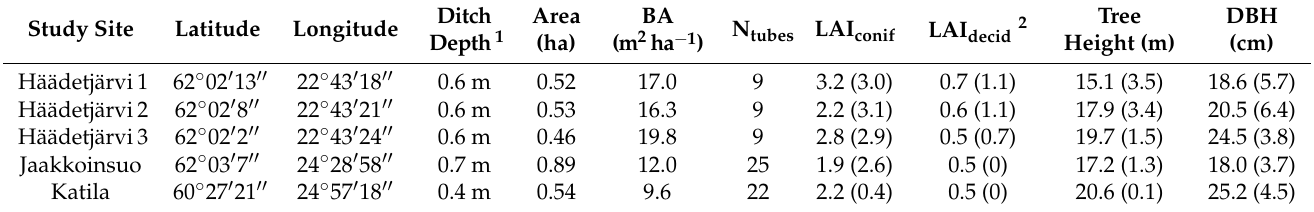
Table 1. Characteristics of the study sites. Tree stand characteristics refer to the adjacent unharvested stand. The standard deviation is presented in parenthesis. BA = stand basal area; N tubes = number of manual water table measurement points; LAI = average leaf area index (one sided) of coniferous (LAI conif ) or deciduous (LAI decid ) tree species after harvesting; tree height = arithmetic mean height of the tree stand in the unharvested stand; DBH = arithmetic mean of the diameters at breast